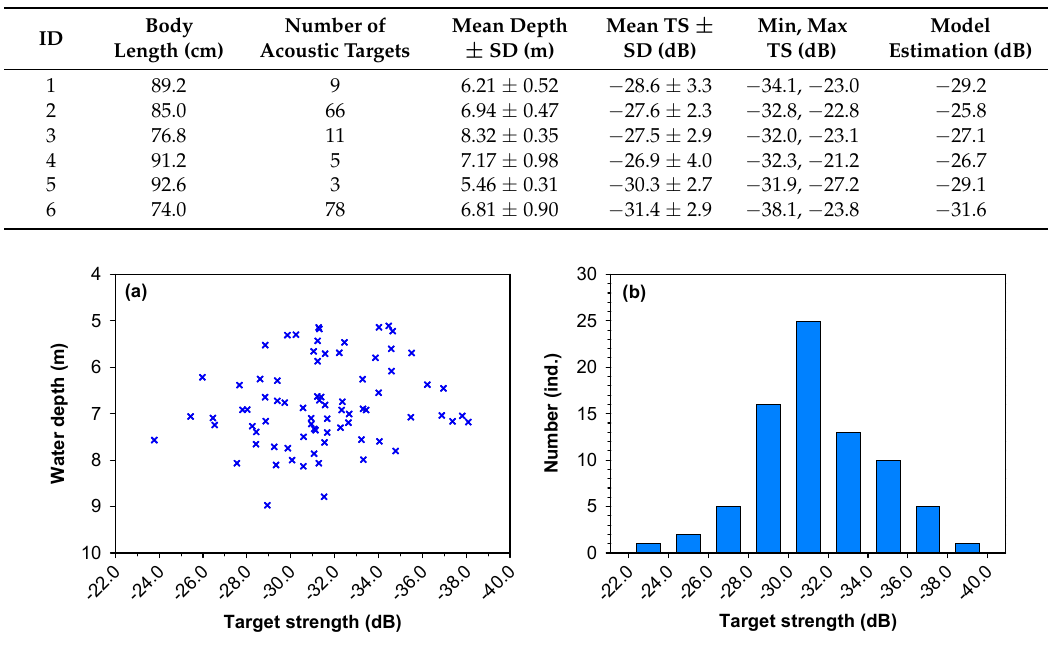
Figure 4. TS of the Chinese sturgeon (Table 4, No. 6 specimen; BL = 74.0 cm) measured in a 10 m deep net cage: ( a ) relationship between the TS and the distributed water depth; and ( b ) interval distribution of